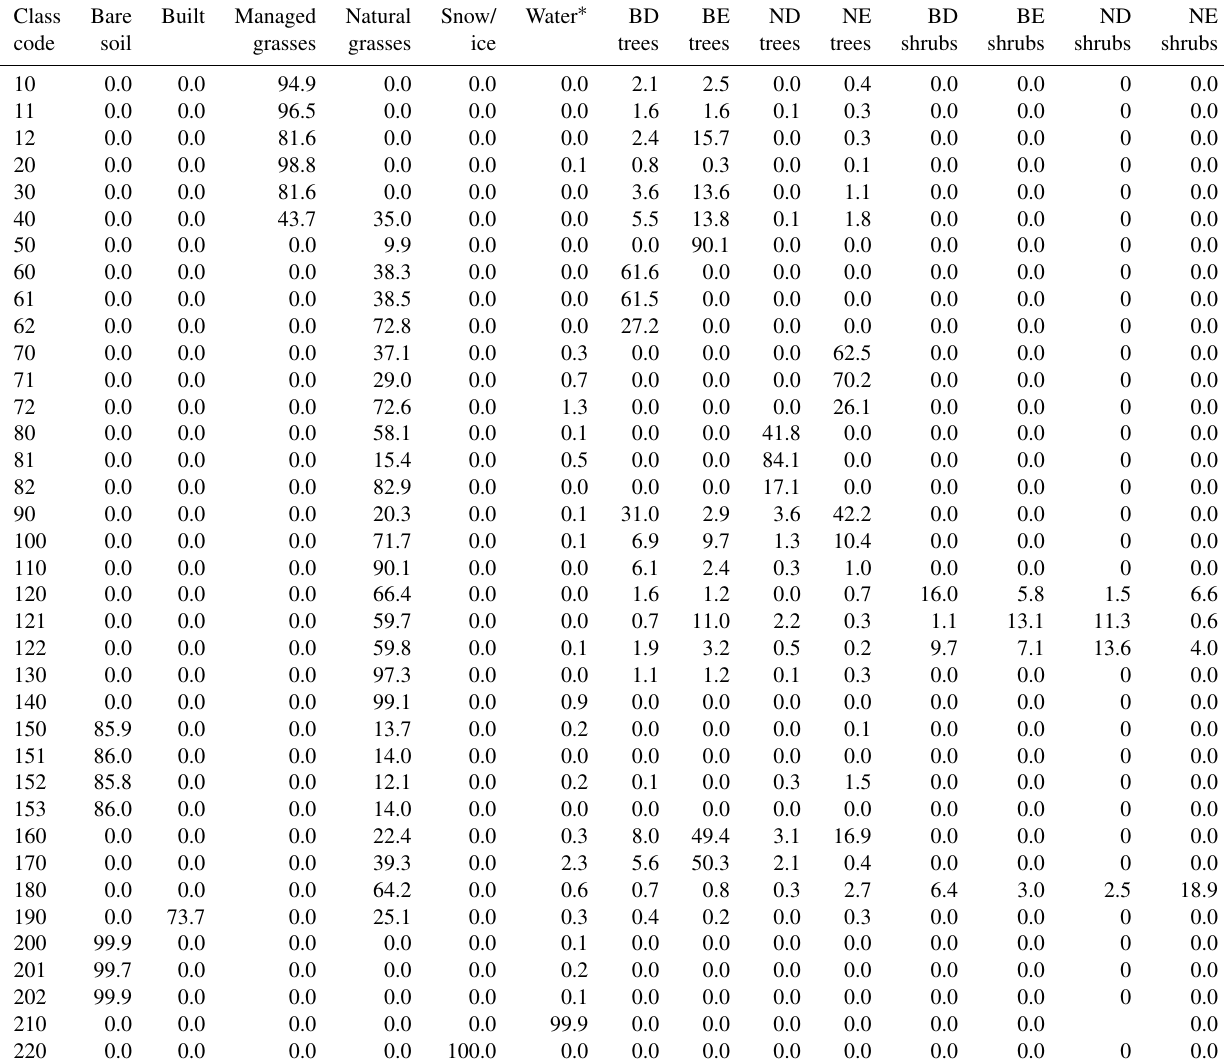
Table 4. Percentage PFT composition by class for 2010 calculated as an area-weighted mean over all pixels of the class globally.